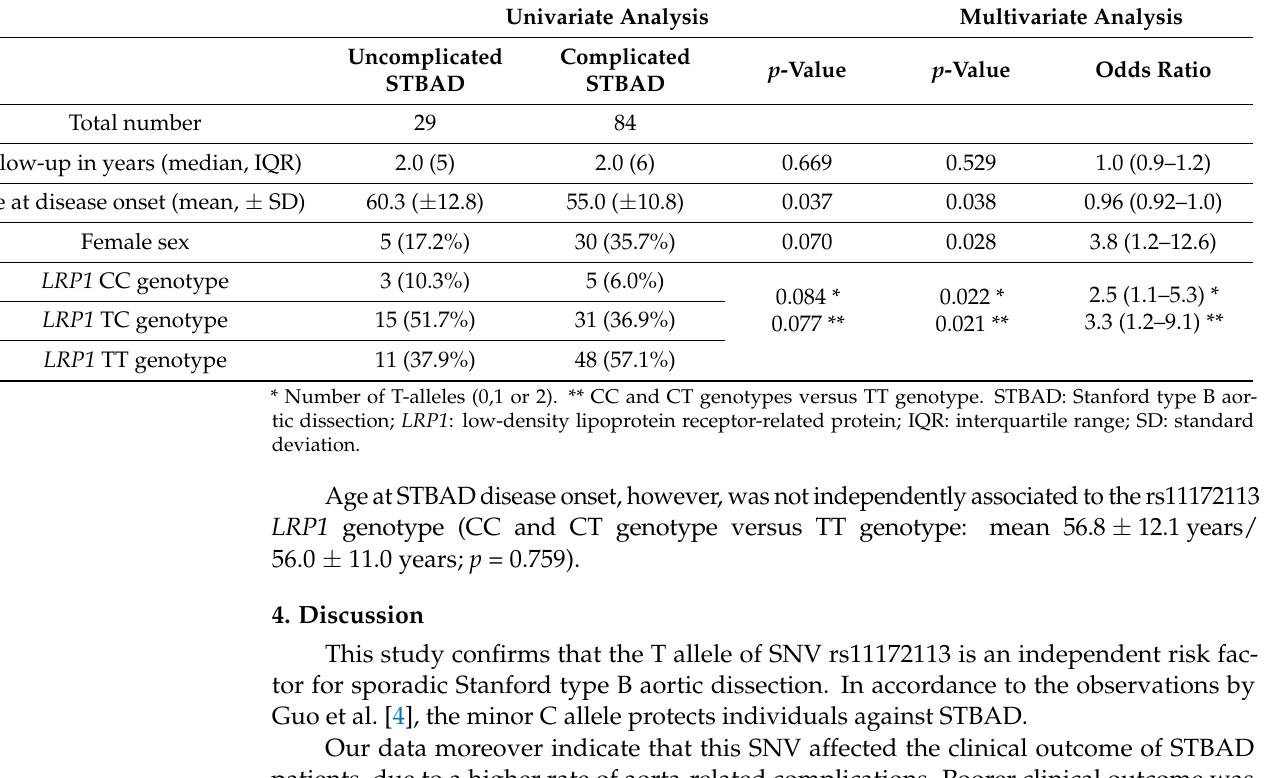
Table 2. Comparison of the STBAD LRP1 genotypes with clinical parameters and disease outcome. Univariate Analysis Multivariate Analysis Uncomplicated Complicated p -Value p -Value Odds STBAD STBAD